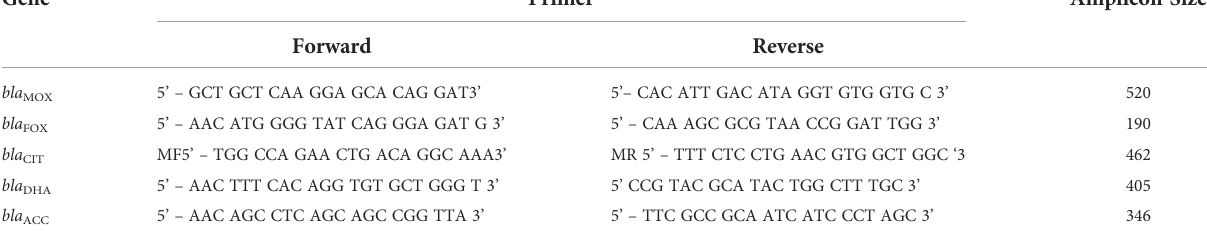
TABLE 1 Primer sequences for target